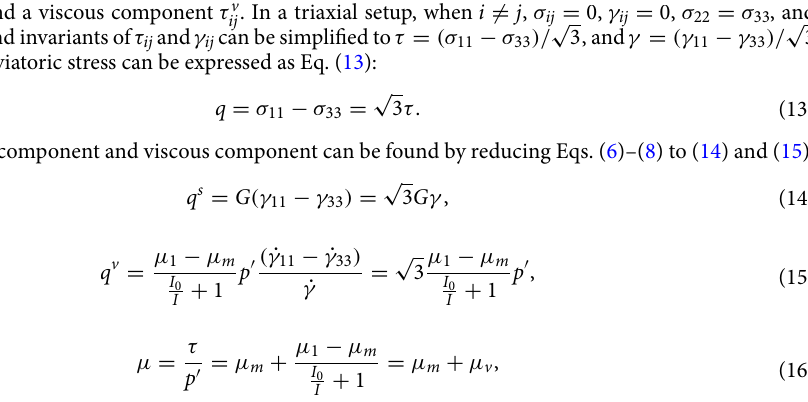
ence curve of experiment data, the black solid line is the simulated deviatoric stress, and the green solid line is the simulated reference curve. In Fig. 3b, the red dotted line is the experimental line and the black solid line is